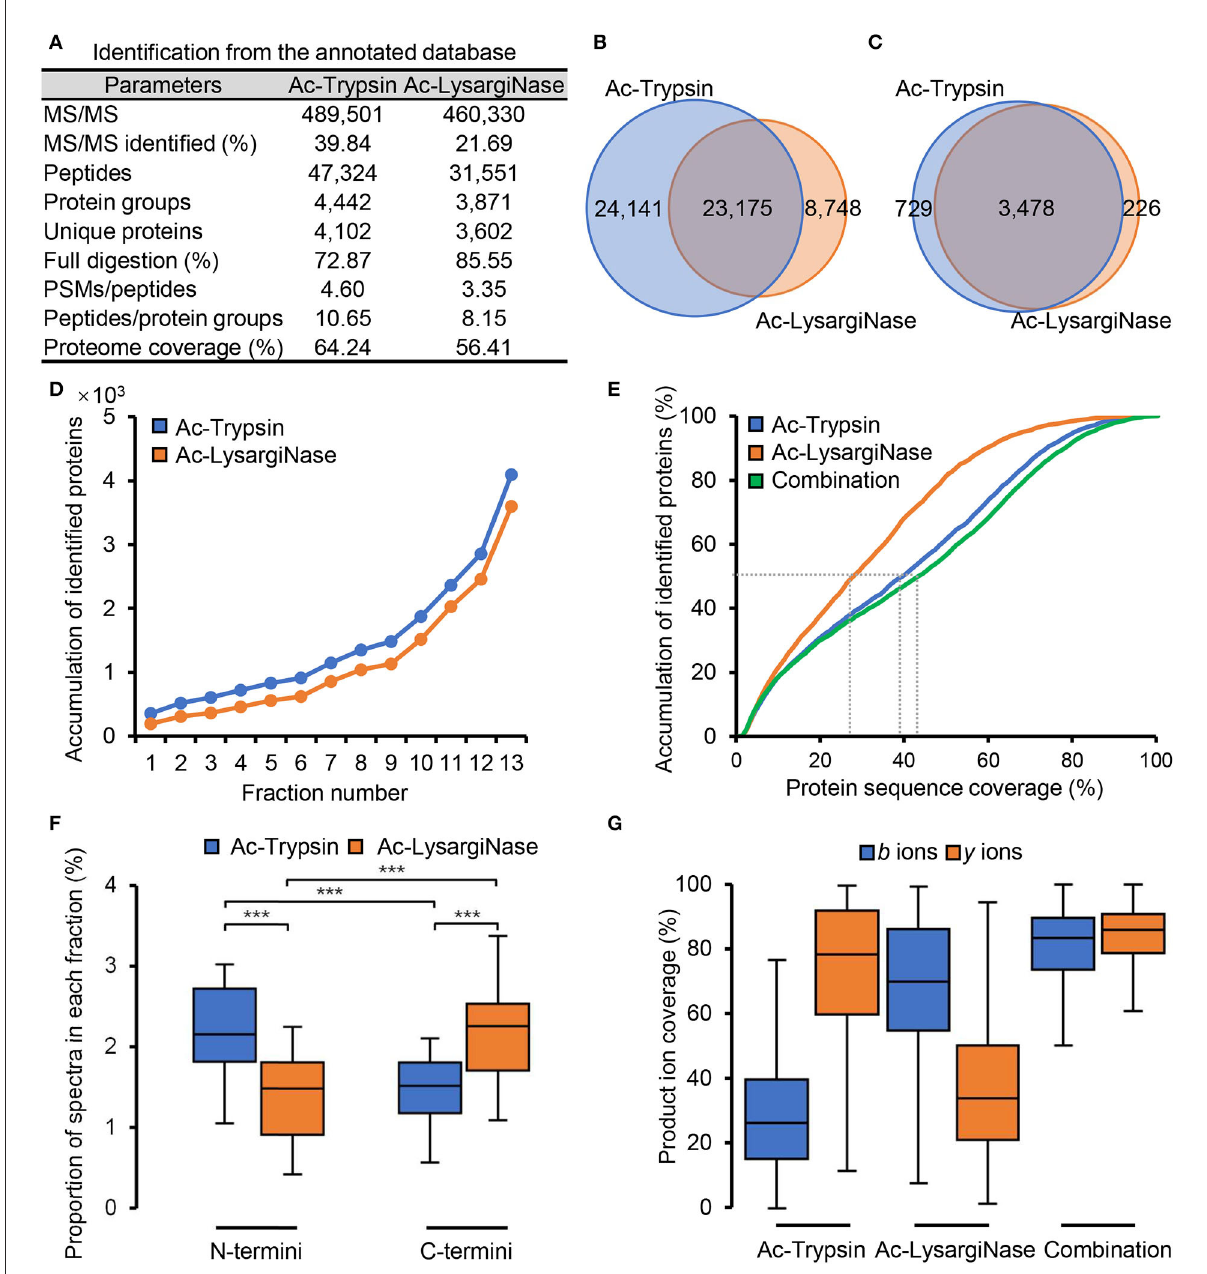
FIGURE2 Mirror proteases helpfully improved the proteome coverage of M. smegmatis MC 2 155 based on the annotated database searching. (A) The application of Ac-Trypsin and Ac-LysargiNase in proteomics of M. smegmatis MC 2 155. Comparison of the identified peptides (B) and proteins (C) by Ac-Trypsin and Ac-LysargiNase. (D) Protein identification saturation using gel-separation methods by Ac-Trypsin and Ac-LysargiNase. (E) Comparison of the protein sequence coverage by single protease and combined mirror proteases. (F) The proportion of the N-terminal and C-terminal spectra in each fraction from Ac-Trypsin and Ac-LysargiNase digests. (G) Comparison of the ion coverages from single protease and combined mirror proteases for annotated peptides. Statistically significant differences by student’s t -test are indicated for p values of * p < 0.05, ** p < 0.01, and *** p <